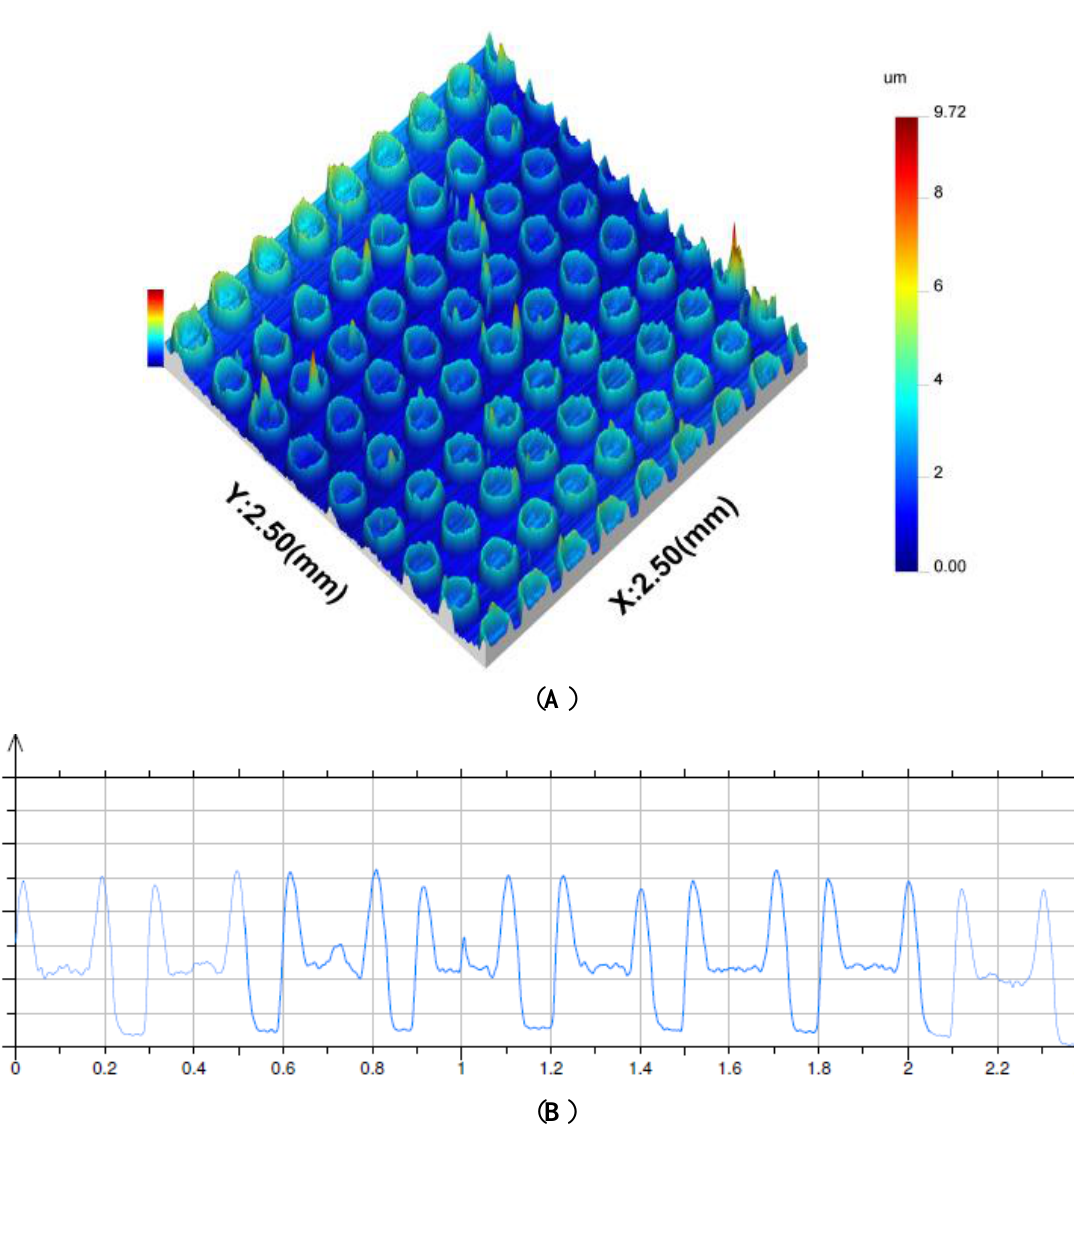
Figure 1. Profilometer image of G. oxydans 30 × 30 latex dot arrays ink-jet printed on polyester sheet, two droplets per dot, one-to-four diluted ink ( A , B ) or three droplets per dot, one-to-two diluted ink ( C , D ). 3D profile of a 2.5 × 2.5 mm 2 scanned area of a dot array ( A , C ); profile of the section line corresponding approximately to the centers of dots belonging to a row or column ( B , D